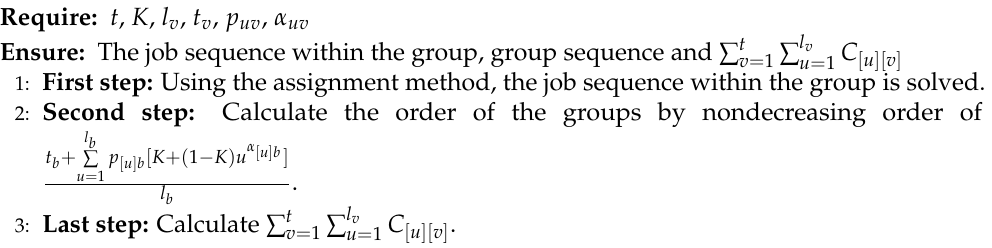
= p [ K + ( 1 − K ) s α [ u ][ v ] ] , GT , t [ u ][ v ] [ u ][ v ]